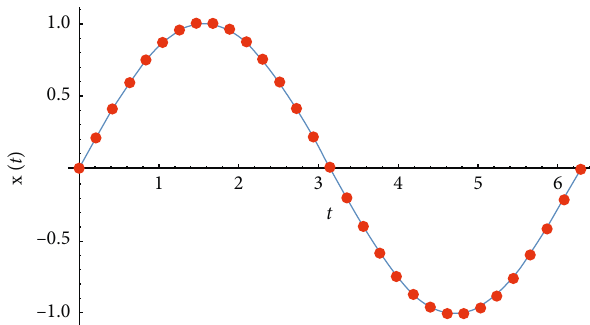
Figure 2: Comparison between the Galerkin solution and the Runge–Kutta numerical